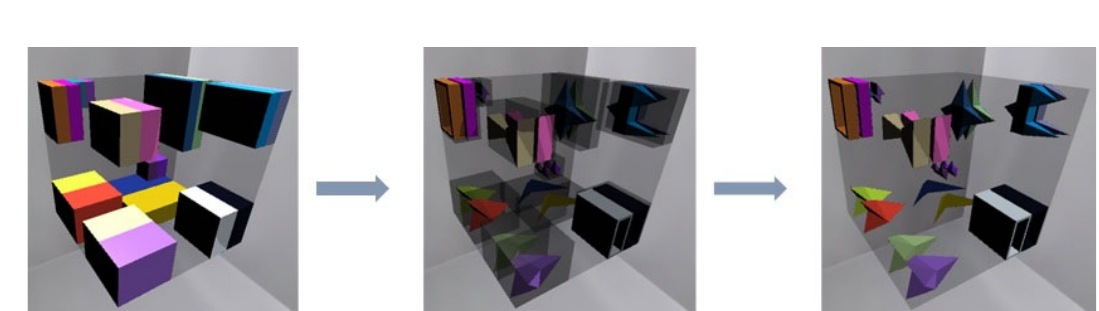
Fig. 3. Construction of AABB of two polyhedra